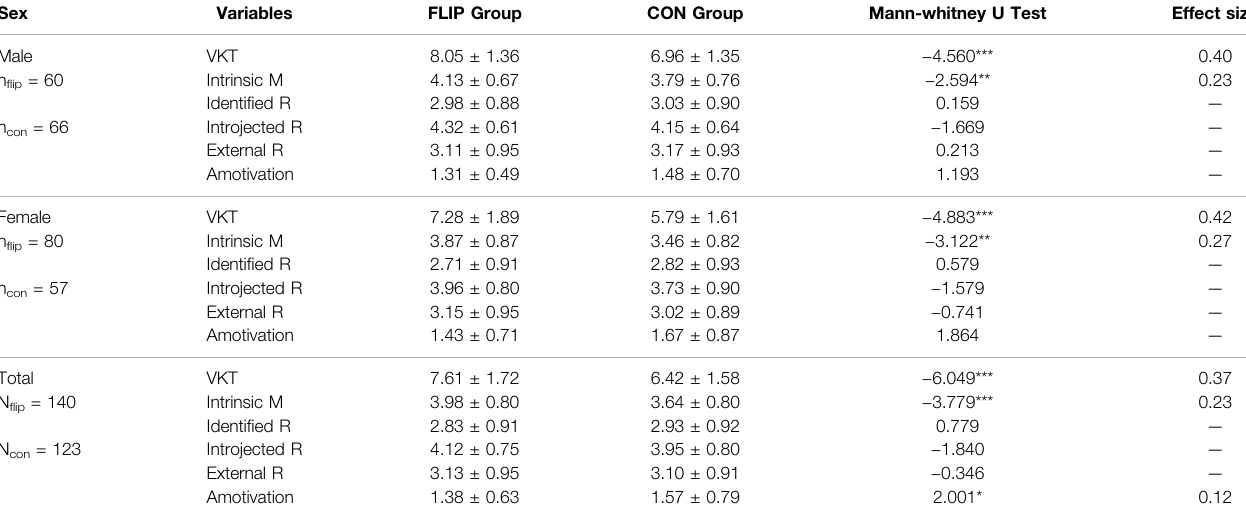
TABLE 4 | Comparing variables between FLIP and CON at post-test using Mann-Whitney U test according to sex (Av ± SD).